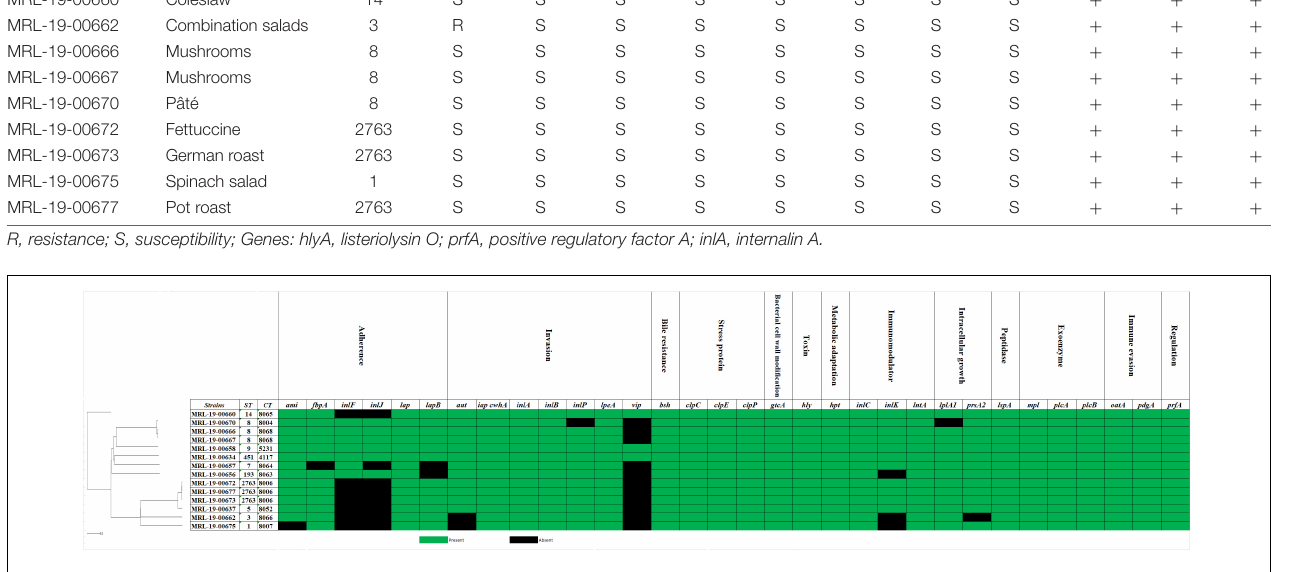
FIGURE 2 | Distribution of virulence genes present in 14 L. monocytogenes strains isolated from ready-to-eat foods. Green boxes indicate the presence of the gene and black boxes its absence. TABLE 4 | Plasmids identified in Listeria monocytogenes strains by plasmidFinder tool. Strains Plasmids Identity (%)